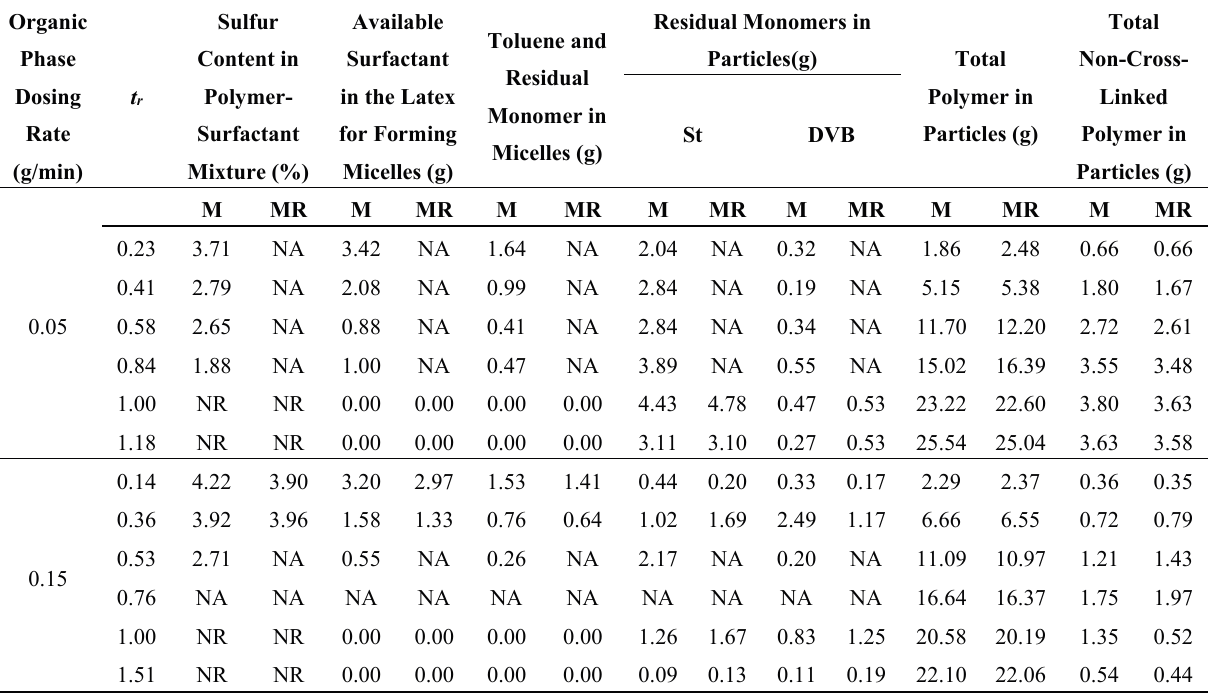
Table 1. Most important data used in the estimation of monomer concentration in particles. Organic Sulfur Available Phase Content in Dosing Polymer- t r Rate (g/min)